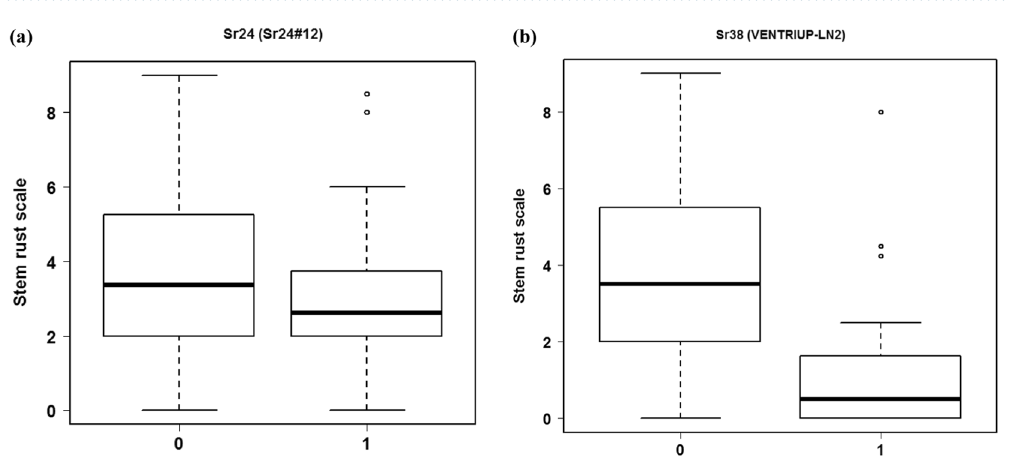
Figure 3. Box plot for the two significant genes in both populations: ( a ) the average of the individuals containing Sr24 (denoted by 1) in the DUP2015 population and the individuals which do not have this gene (denoted by 0). ( b ) The average of the individuals containing Sr38 (denoted by 1) in the TRP2015 population and the individuals which do not have this gene (denoted by